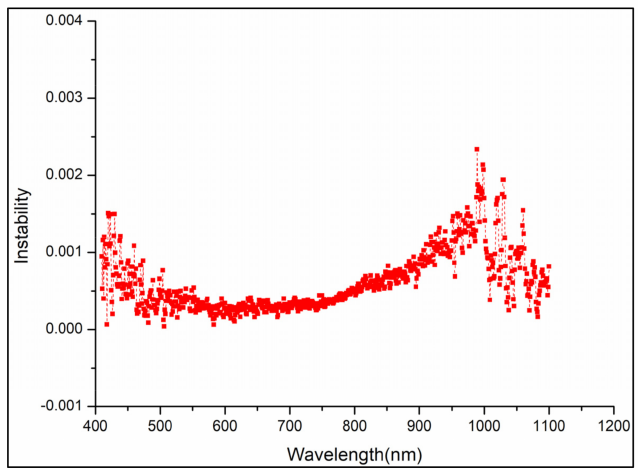
Figure 7. Radiance instability of the integrating sphere in 30 min.